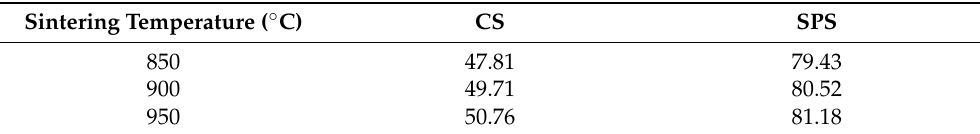
Table 1. Comparison of relative density of CS and SPS Ca 3 Co 4 O 9 samples at 850, 900, and 950 ◦ C.